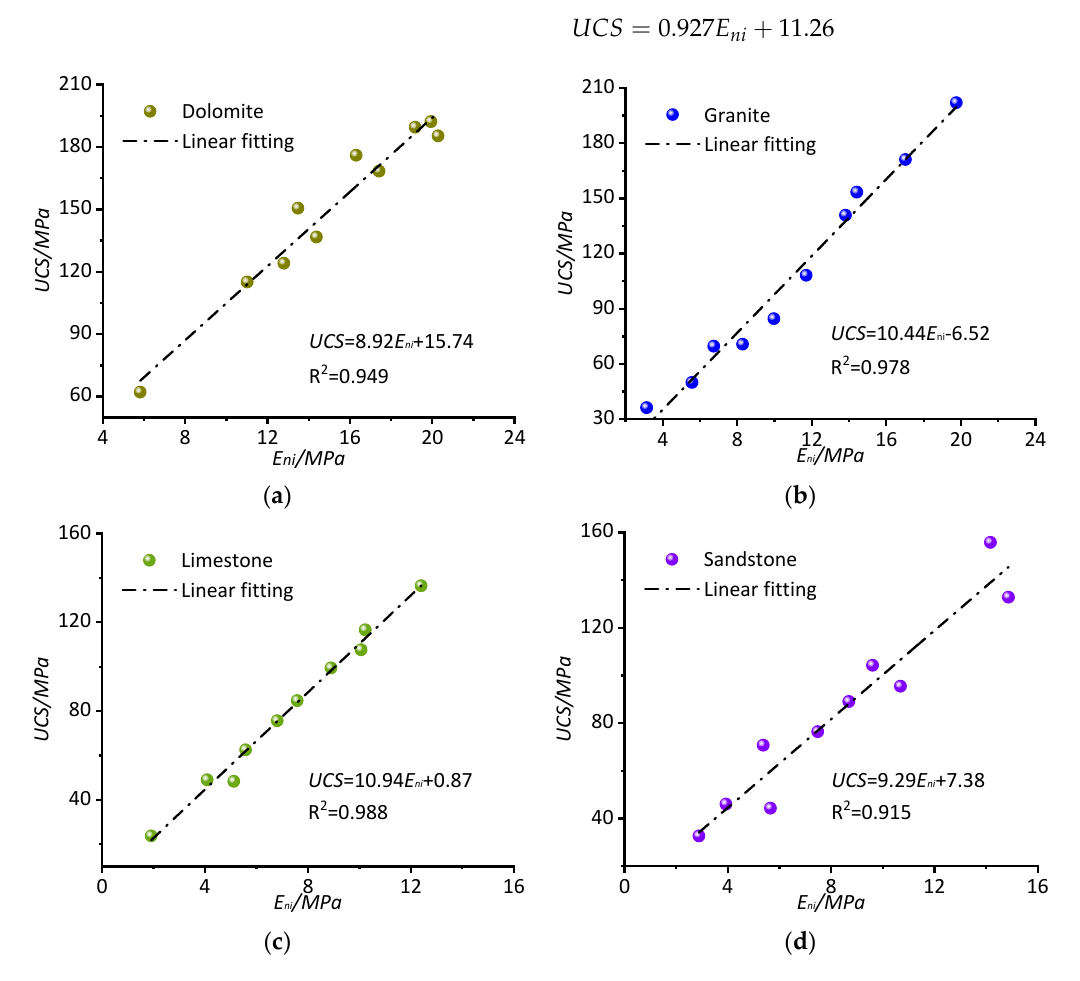
Figure 13. Correlations between UCS and E ni for different rock types. ( a —Dolomite; b —Granite; c —Limestone; d —Sandstone).